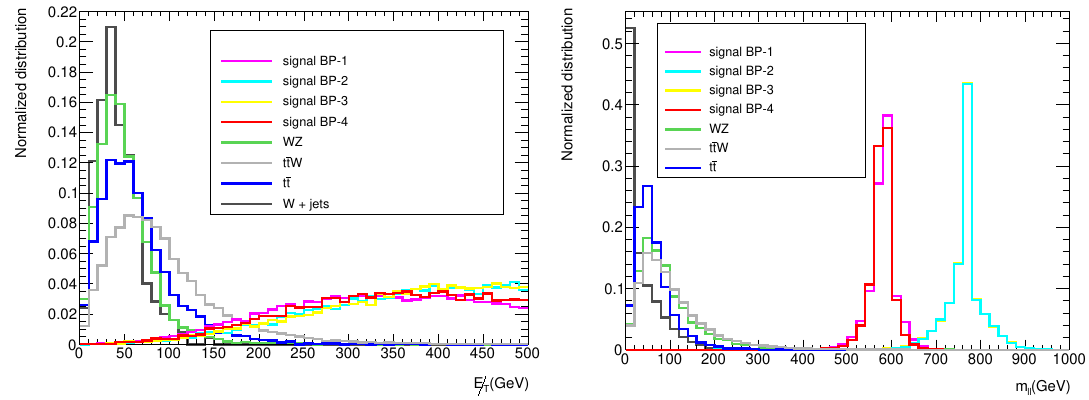
Figure 10 . Distribution of =E T (left) and invariant mass(right) of same-sign dileptons for the four signal BPs and backgrounds in case I.